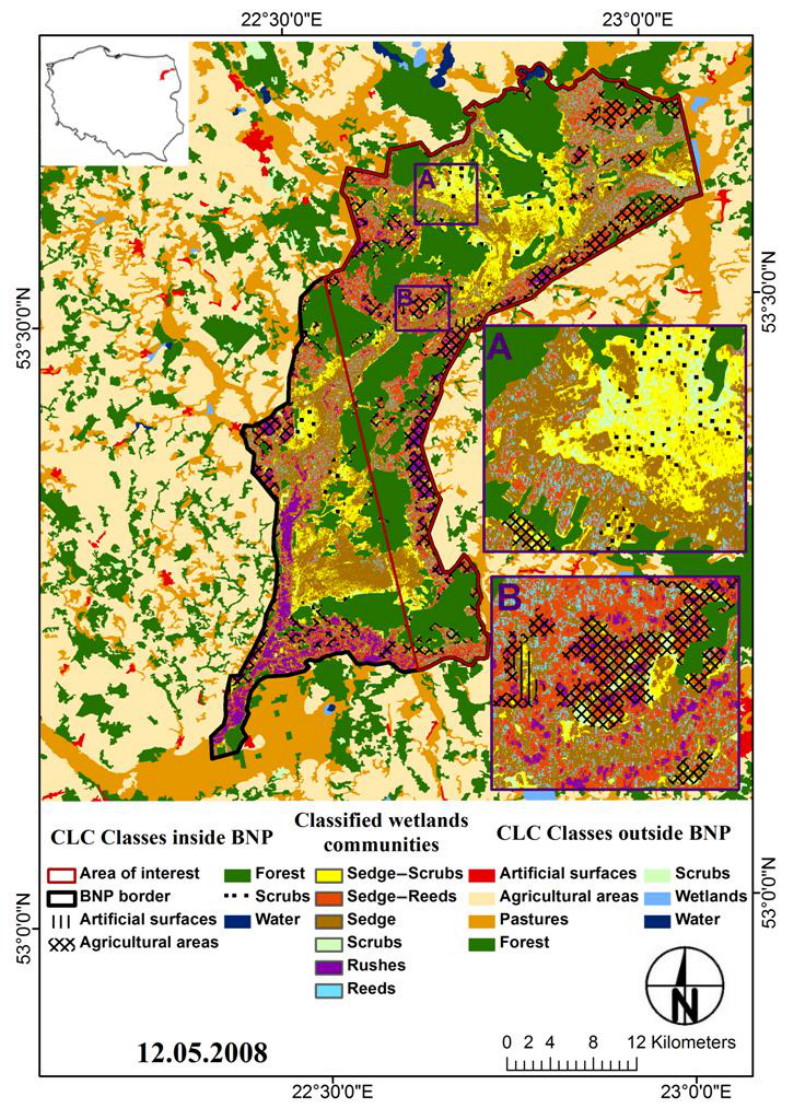
Figure 7. Map of wetland communities classified based on PALSAR HV image registered on 12 May 2008, placed on CLC